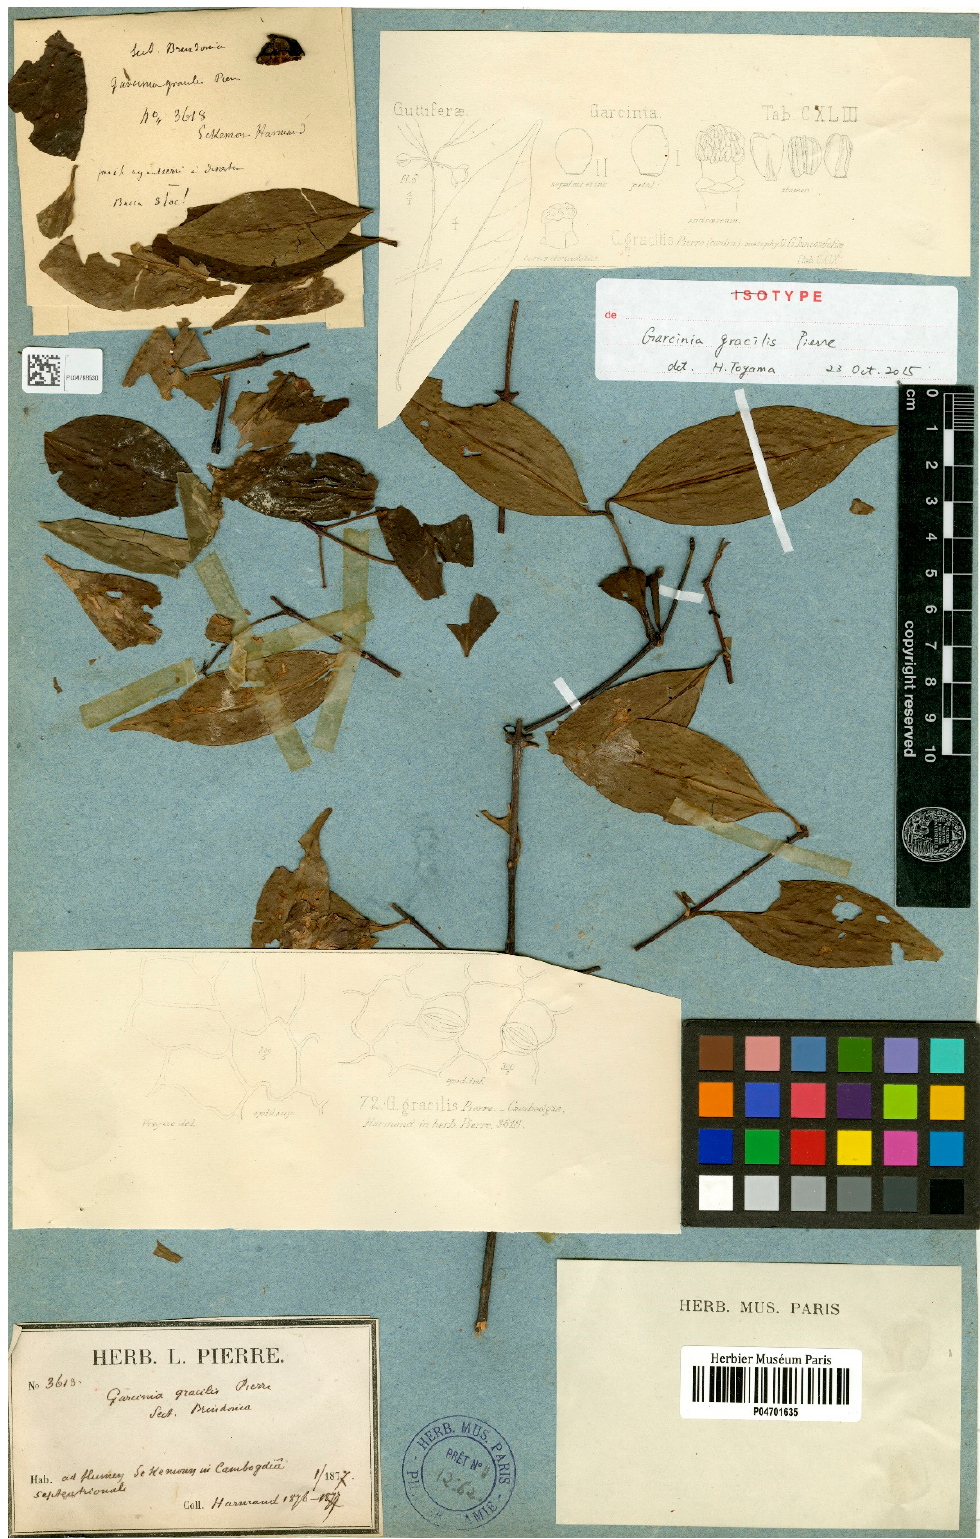
Figure 6. Lectotype of Garcinia gracilis , Harmand 3618 (P [P04701635!]) from Cambodia, Ad flumen Se Kemoun, with male flowers (http://coldb.mnhn.fr/catalognumber/mnhn/p/p04701635, accessed on 16 February 2022).